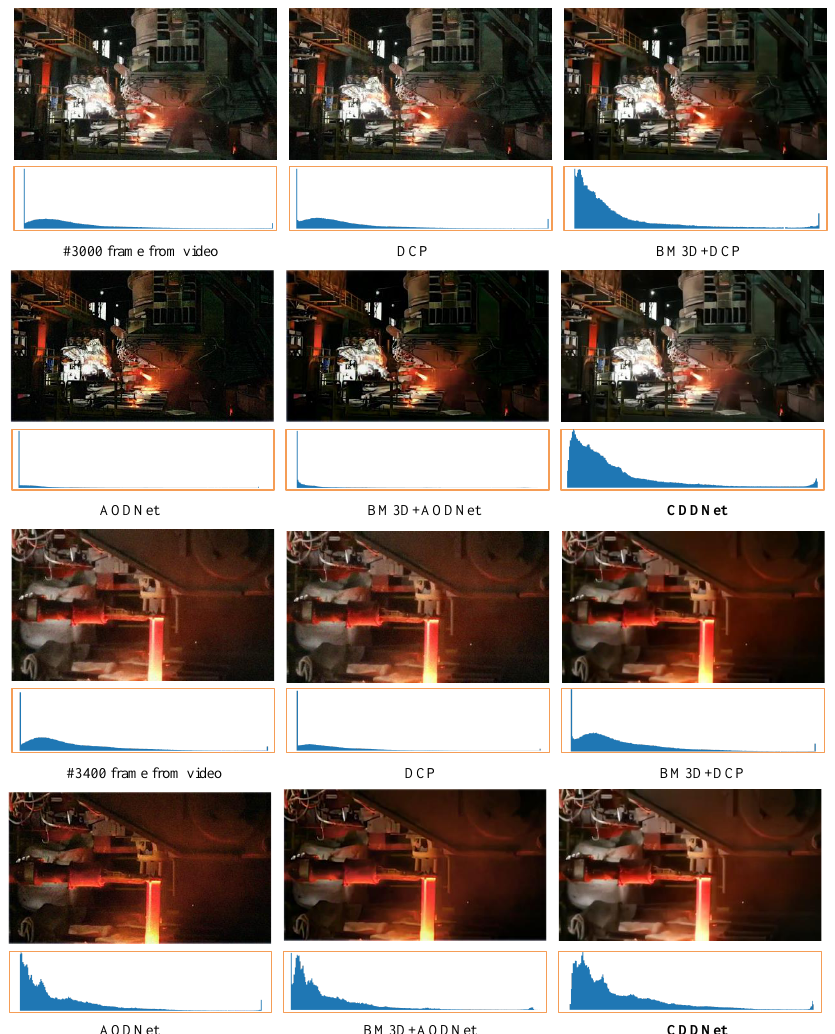
Figure 4. Hazy and noisy frames from video. CDDNet restores images with high visual